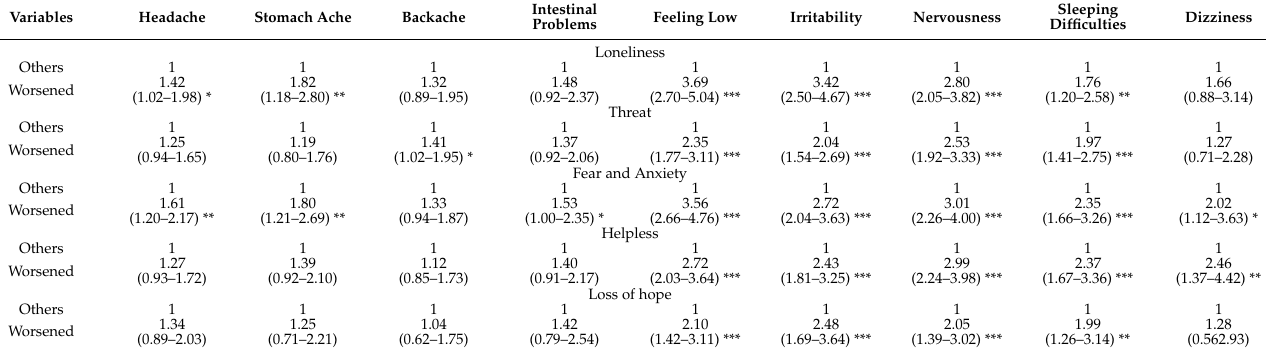
Table 5. Associations of increased frequencies of health complaints with worsened feelings adjusted for age, gender and education (OR, 95%